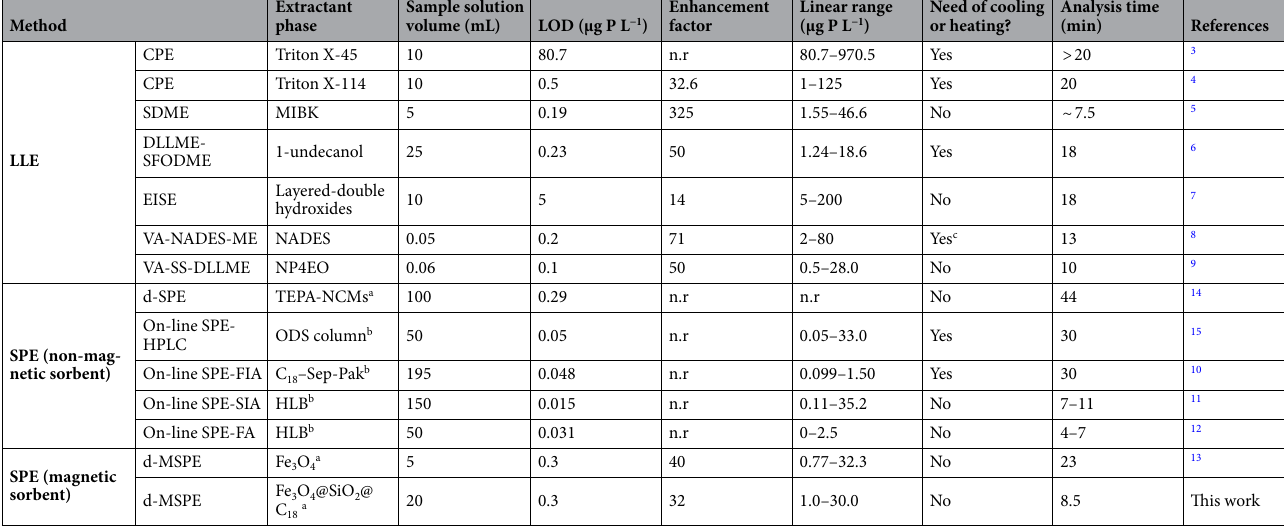
Table 2. Comparison of analytical performance of the proposed d-MSPE method with other extraction/ preconcentration methods for colorimetric determination of o -PO 4 3− in water samples. LLE: liquid– liquid extraction; CPE: cloud-point extraction; SDME: suspended droplet micro-extraction; DLLME- SFODME: dispersive liquid–liquid micro-extraction-solidified floating organic drop micro-extraction; EISE: electrostatically induced stoichiometric extraction; VA-NADES-ME: vortex-assisted natural deep eutectic solvent micro-extraction; VA-SS-DLLME: vortex-assisted based supramolecular solvents-dispersive liquid–liquid micro-extraction; SPE: solid-phase extraction; d-SPE: dispersive solid-phase extraction; TEPA-NCMs: Tetraethylenepentamine-functionalized nano-size meterials; FIA: Flow injection analysis; SIA: Sequential injection analysis; FA: flow analyzer; MIBK: Methyl isobutyl ketone; NADES: natural deep eutectic solvents; NP4EO: non-ionic nonylphenol tetra-ethoxylate ; HLB: hydrophilic-lipophilic balance; HPL: high performance liquid chromatography; ODS: octadecylsilane; LOD: limit of detection; n.r.: Not reported; a : in-laboratory synthesized sorbent; b : commercial sorbent; c : requires heating to prepare